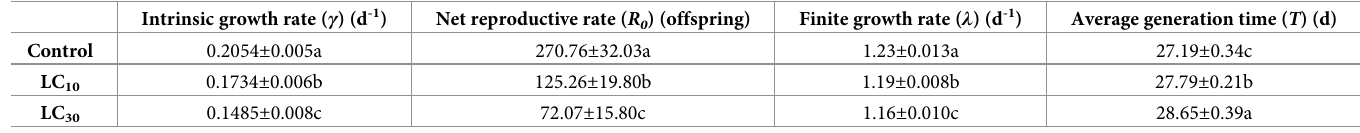
Table 2. Mean ( ± SE) life-table parameters of S . exigua treated with TCAP. Intrinsic growth rate ( γ ) (d -1